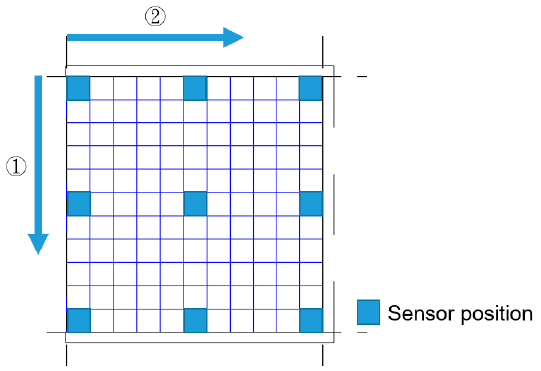
Figure 5. Distribution of sensor locations.